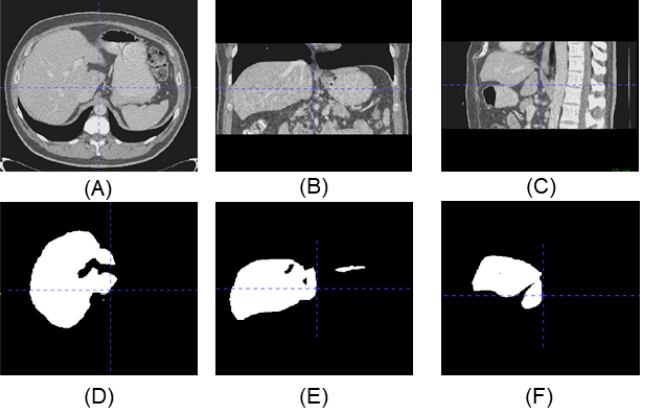
Figure 1. Upper line is the three-view drawing of the liver CT, lower line is the corresponding label. ( A ) Top view of the CT. ( B ) Side view of the CT. ( C ) Front view of the CT. ( D ) Top view of the label. ( E ) Side view of the label. ( F ) Front view of the label.